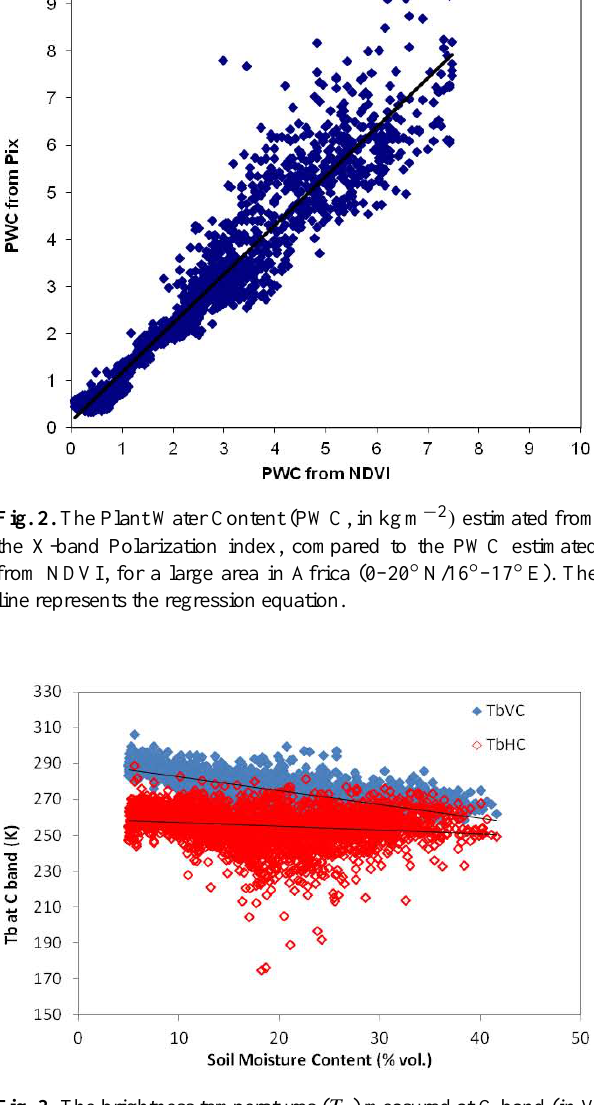
Fig. 3. The brightness temperatures ( T b ) measured at C-band (in V and H pol.) in Australian and Mongolian test sites as a function of volumetric SMC (m 3 m − 3 )